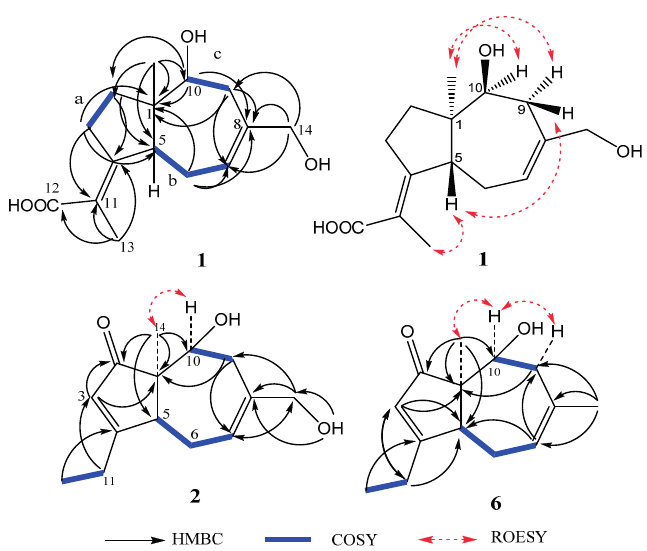
Figure 2. Key HMBC, COSY, and NOESY correlations of 1 , 2 , and 6